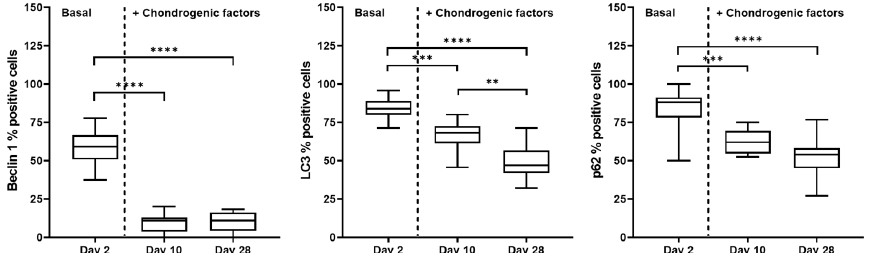
Figure 8. Immunohistochemical analysis of Beclin 1, LC3, and p62 proteins on chondrogenic differentiated hASCs embedded in VG-RGD at days 2, 10, and 28. Quantification of the percentage of positive cells. Data were expressed as percentage of positive cells and represented as a boxplot with median, minimum, and maximum. Kruskal–Wallis with Dunn’s multiple comparisons test was used for statistical analysis: * indicates differences along time points; ** p < 0.005, *** p < 0.0005, **** p < 0.0001.